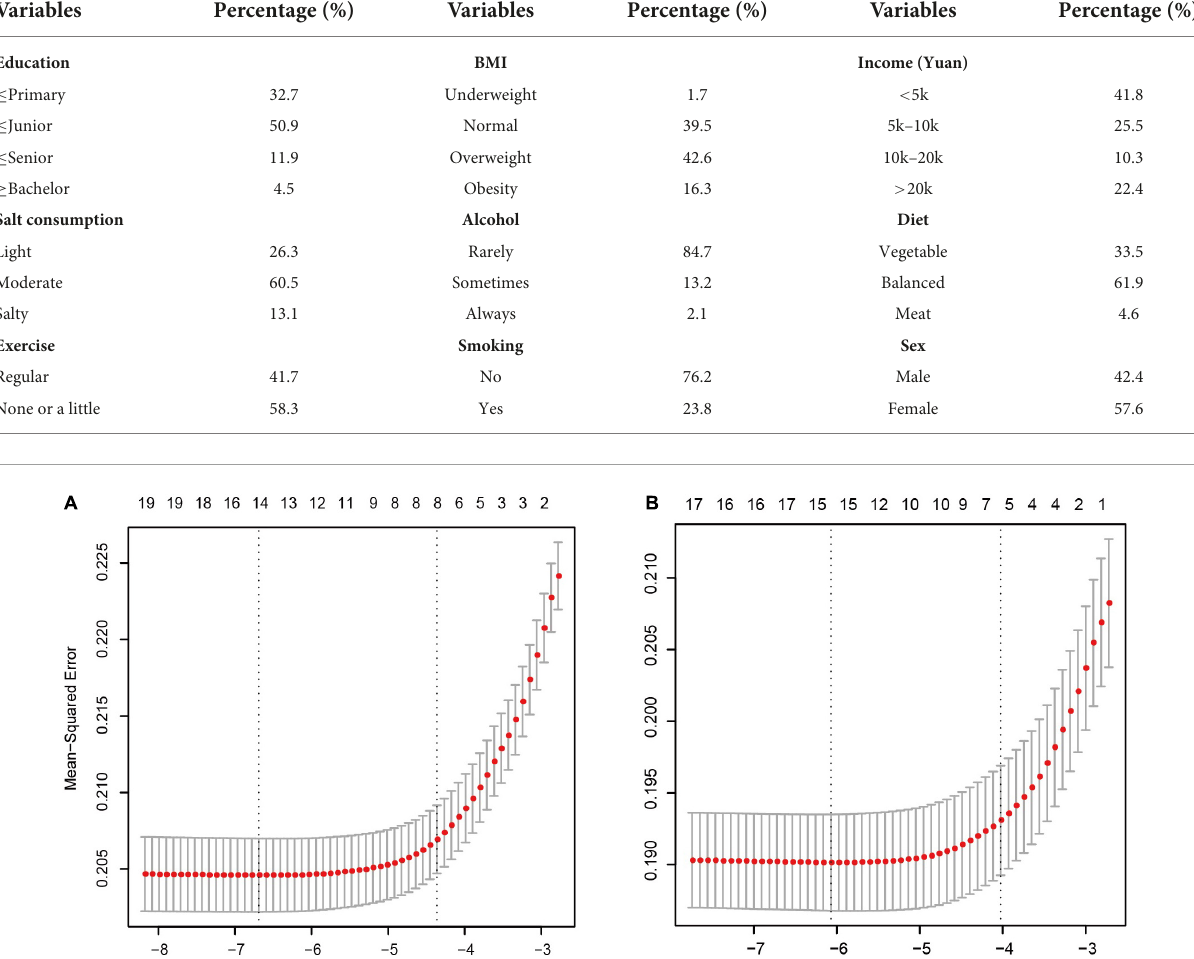
TABLE 2 Clinical parameters of study subjects (qualitative ones).